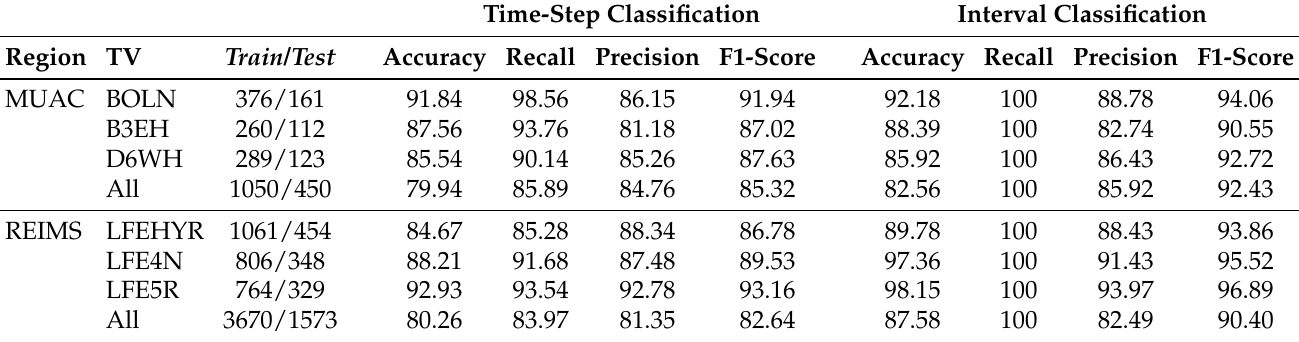
Table 3. Performance of the RNN-CNN cascade model for different TVs in the MUAC and REIMS regions at the time-step level and at the interval level. Train/Test column shows the number of 30 min intervals